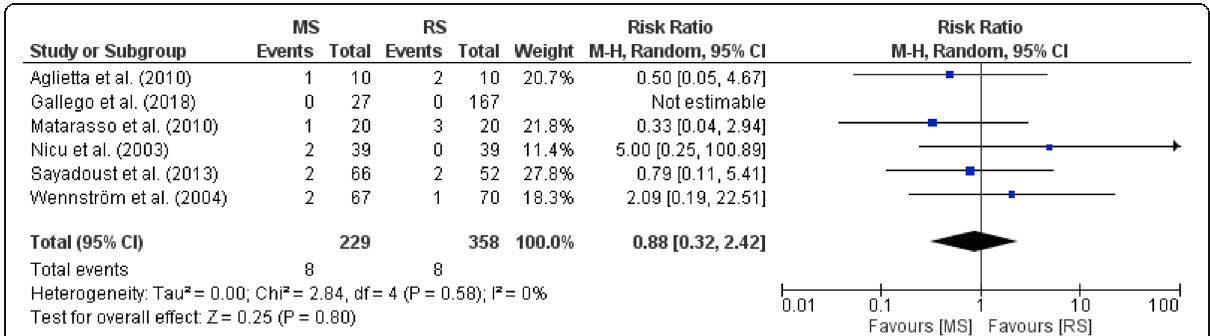
Fig. 3 Forest plot on differences in implant survival between MS and RS groups in all included studies